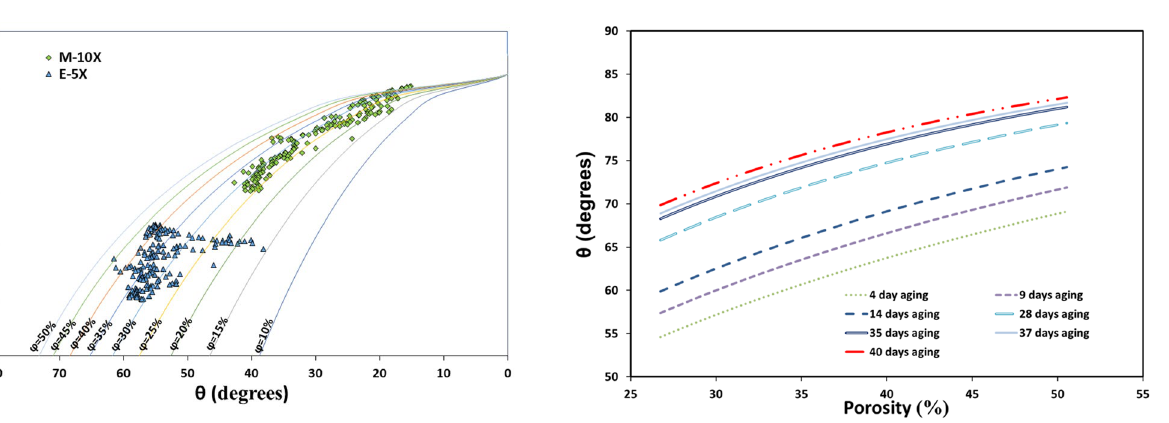
Fig. 9 Relation between the porosity and calculated contact angle at a displacement temperature of 90 ºC for the Rørdal samples